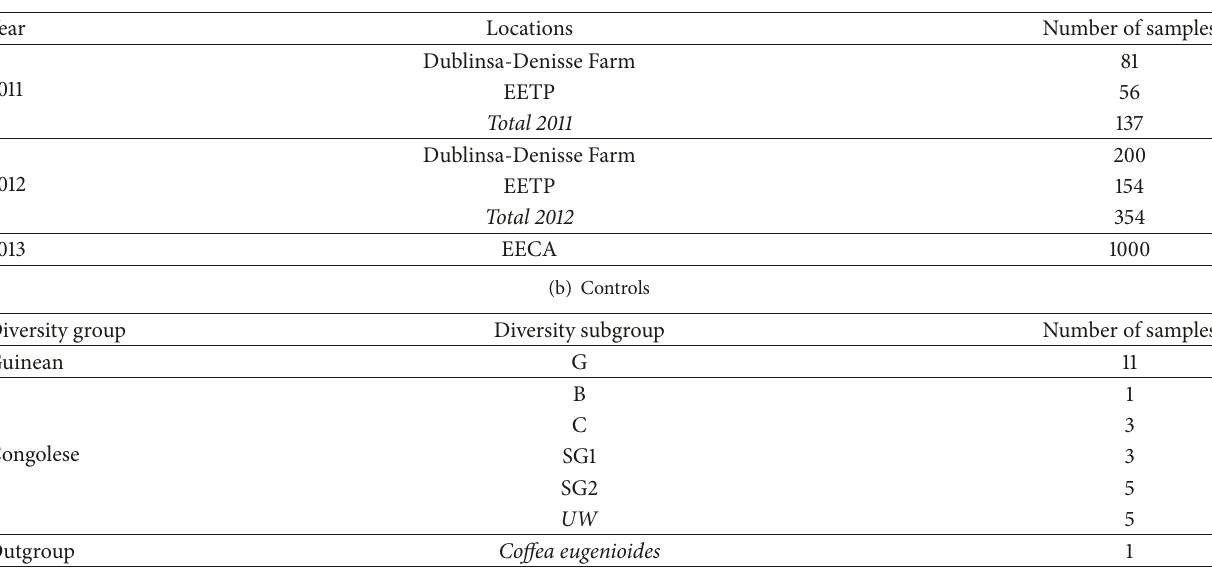
Table 1: Genetic material analyzed and controls used in the genotypic